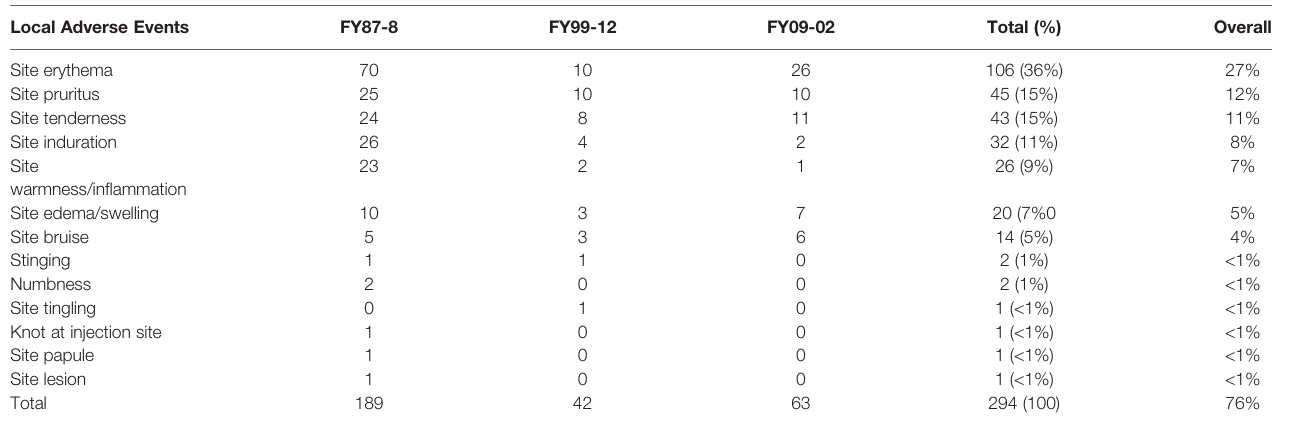
TABLE 5 | Local Adverse Events (AEs) de fi nitely related to the vaccine (1987 –